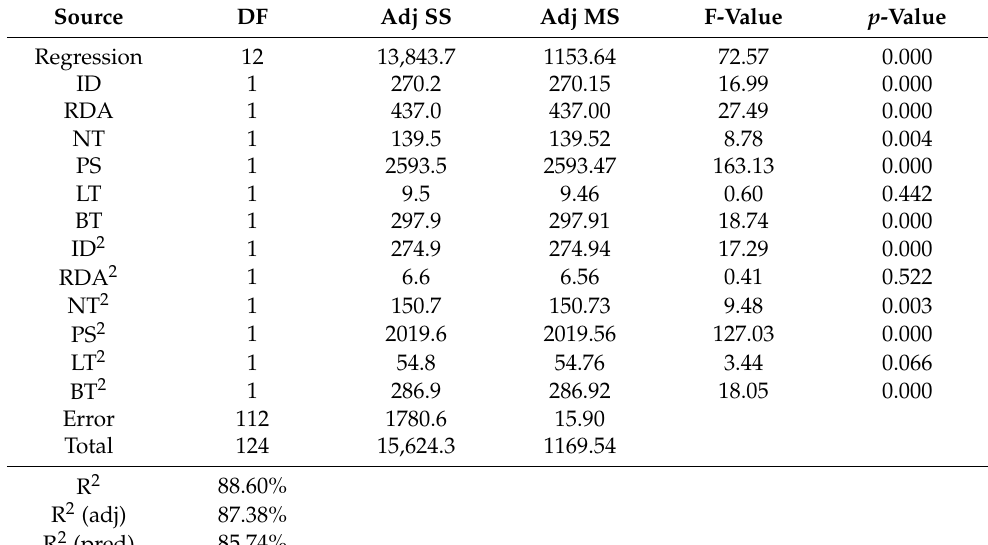
Table 6. Polynomial ANOVA, sB vs. ID, RDA, NT, PS, LT, BT.